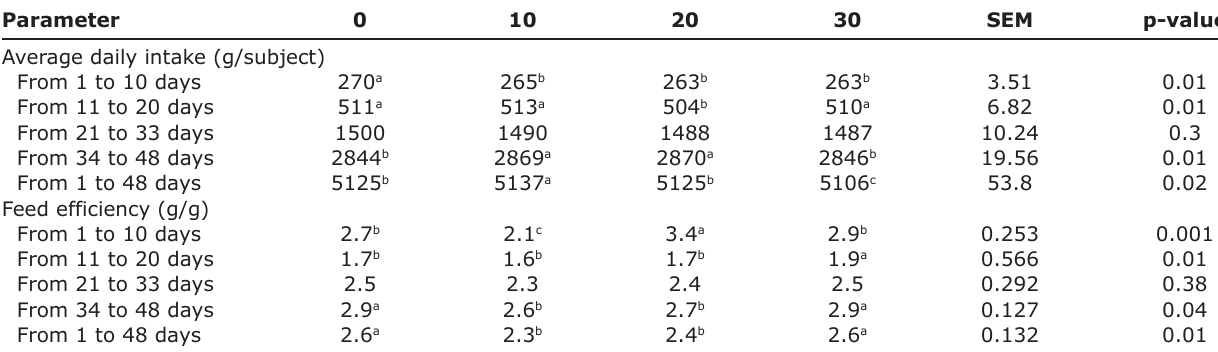
Table-4: Changes in average daily intake and the feed efficiency as a function of the substitution rate. Parameter 0